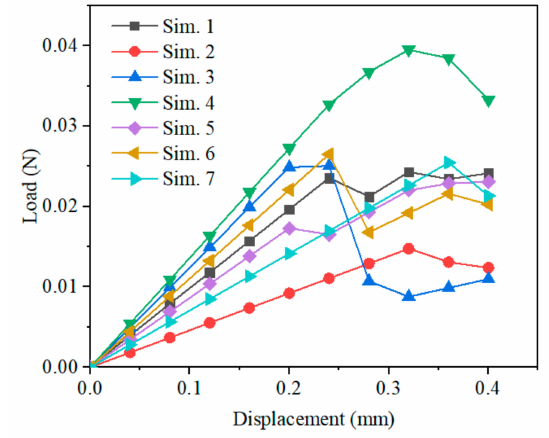
Figure 8. Simulated load–displacement curves from the FE model at room temperature (299 K), where the ratio was 0.5 from crack length to